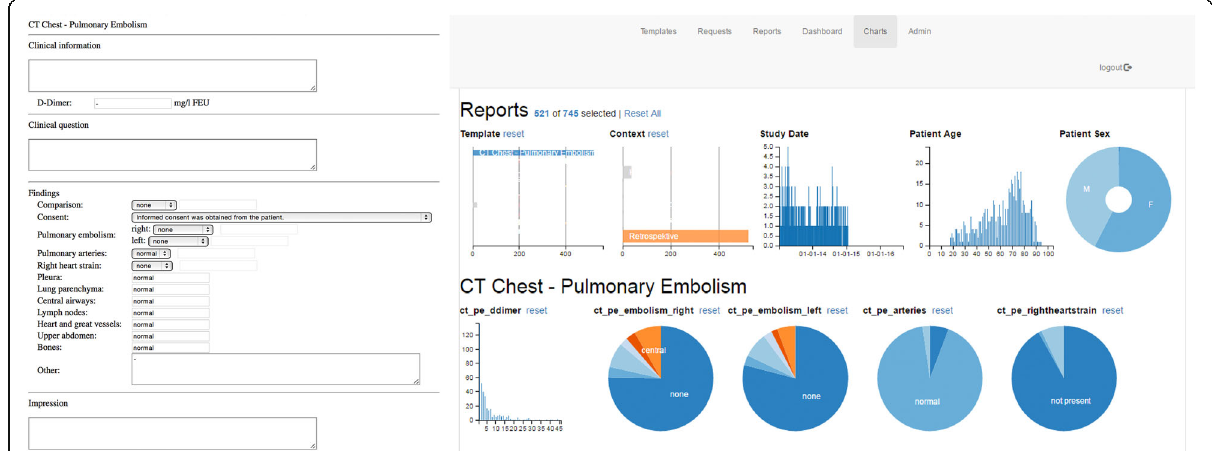
Fig. 2 Example of a structured report template for pulmonary embolism (left), and a dashboard visualising summary results of all reports created with this template (right). Such information could also be used as labels to the corresponding imaging